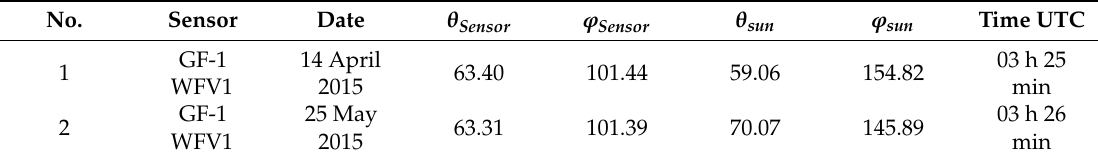
Table 2. GF-1 images